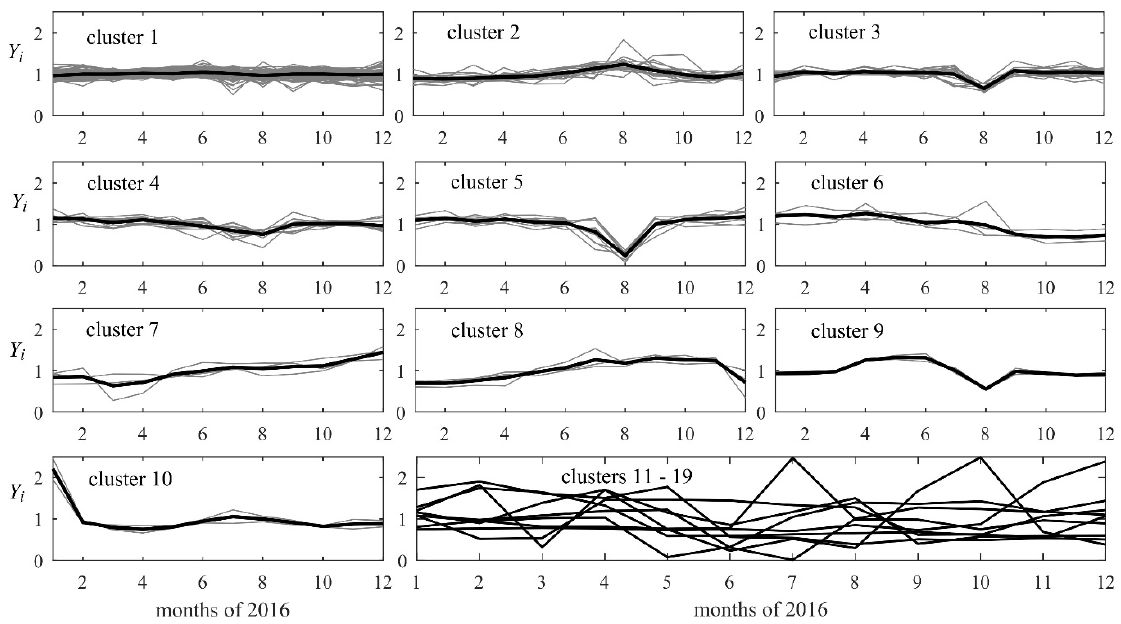
Figure 2. Clusters provided by the best cluster